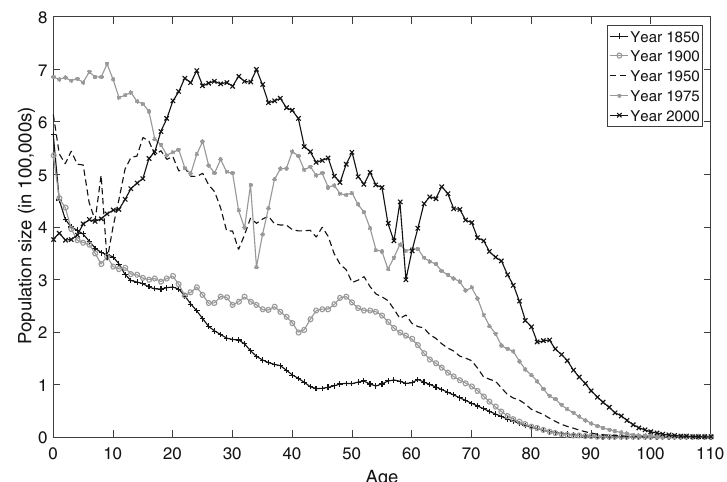
Fig. 2 Spanish population distribution (both sexes combined): Selected years 1850, 1900, 1950, 1975, and 2000. Source Authors’ estimates